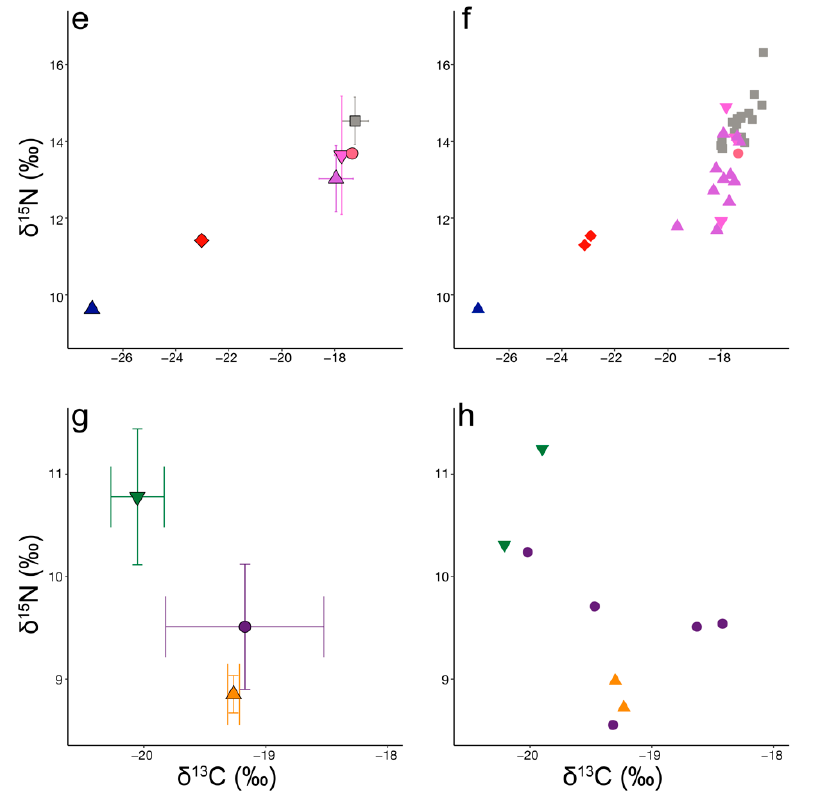
Figure A2. Isotopic values for individual odontocetes stranded in New Zealand between 2010 and 2021 displayed by habitat (Table 1) for ( a , b ) neritic odontocetes, ( c , d ) mesopelagic odontocetes, ( e , f ) bathypelagic odontocetes, and ( g , h ) polar odontocetes. Species denoted by shape and colour, (for legend see Figure A1).